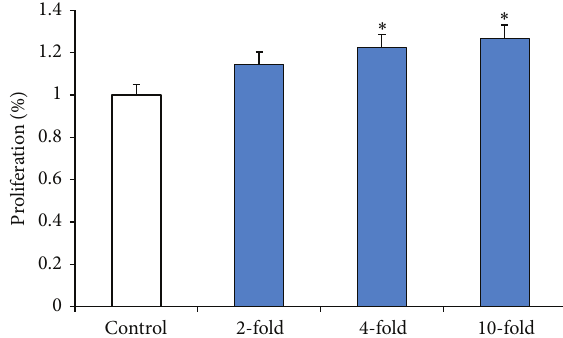
Figure 1: Effect of SW872-conditioned media on proliferation of EGE cells. EGE cells were cultured in 96-well cell culture plate and treated with conditioned media which were diluted from 2- to 10-fold concentrations. Cell proliferation in EGE treated with and without dilutions of SW872-conditioned media was assessed using CyQuant assay as described in Methods. Results are expressed as means ± SE from 3 separate experiments. ∗ Significantly different from the control ( 𝑃 < 0.05 ).